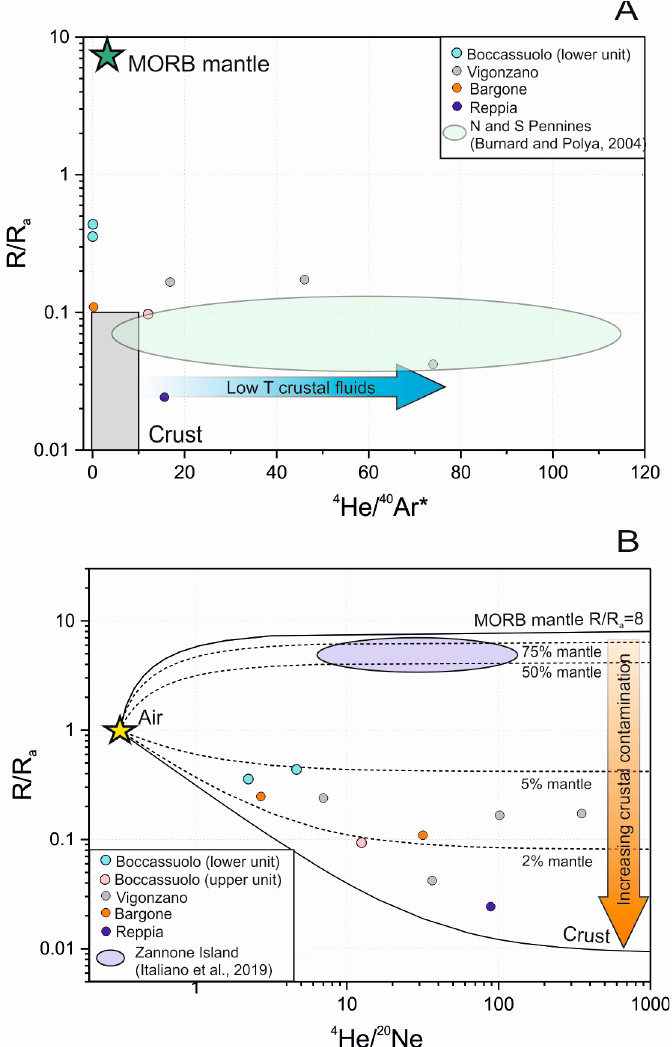
Figure 5. Interpretation of noble gas isotope composition of quartz and sulfide-hosted fluid inclusions from the studied Italian locations; 4 He/ 40 Ar* ( A ) as well as 4 He/ 20 Ne ( B ) data both support a very slight magmatic fluid input for Boccassuolo (lower unit), while results of a fluid–rock interaction in the crust is clearly seen for the other localities (end-members in the R/Ra vs. 4 He/ 20 Ne plot): atmospheric (1 R/Ra, 0.318 4 He/ 20 Ne [46]), crustal (0.02 R/Ra, 1000 4 He/ 20 Ne [47]) and MORB (8 R/Ra, 1000 4 He/ 20 Ne [48]).